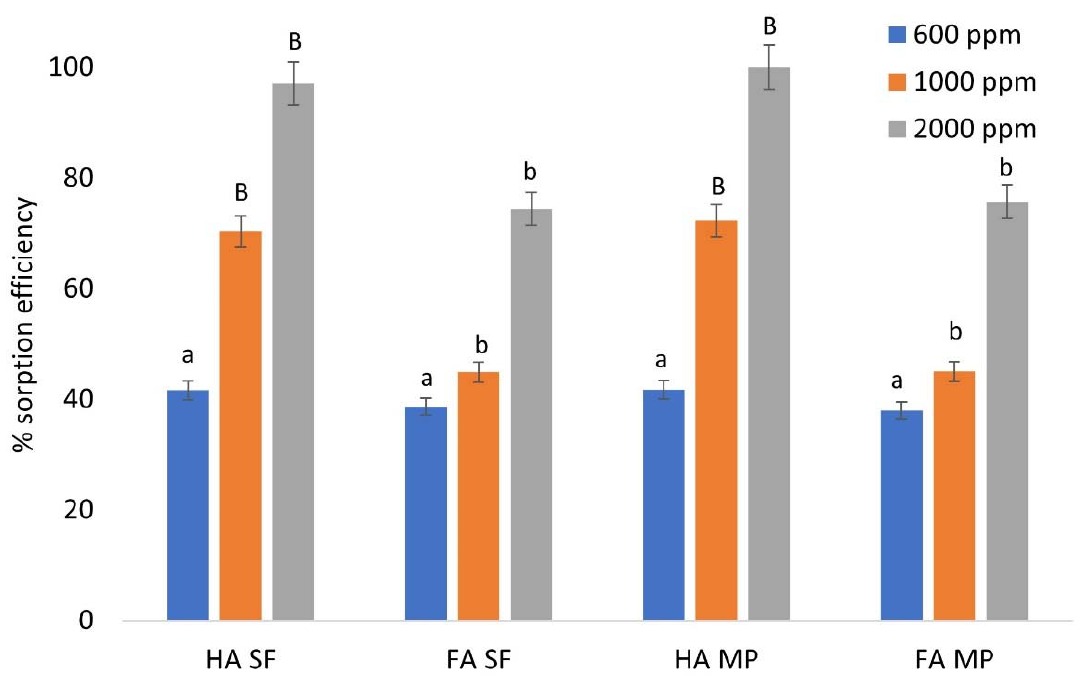
Figure 5. % Sorption efficiency of cypermethrin using humic acid (HA) or fulvic acid (FA) extracted from different concentrations of lignite from South Field (SF) or Mavropigi (MP) mines; bars represent the average sorption efficiency of five replicate analyses; statistically significant differences ( p < 0.05) are depicted with small and capital letters.